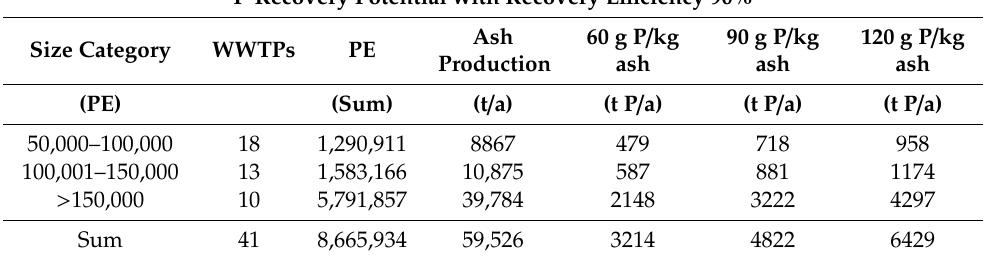
Table 9. ResultsfortheP-recoverypotentialsaccordingtosizecategoriesofWWTPsandmono-incineration ash P-concentration